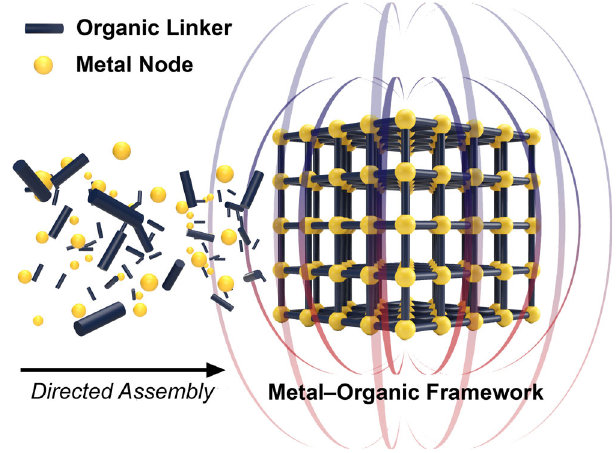
Fig. 1 Control of chemical structure and function. The synthetic versatility and predictability associated with metal – organic frameworks can be leveraged to design new permanent